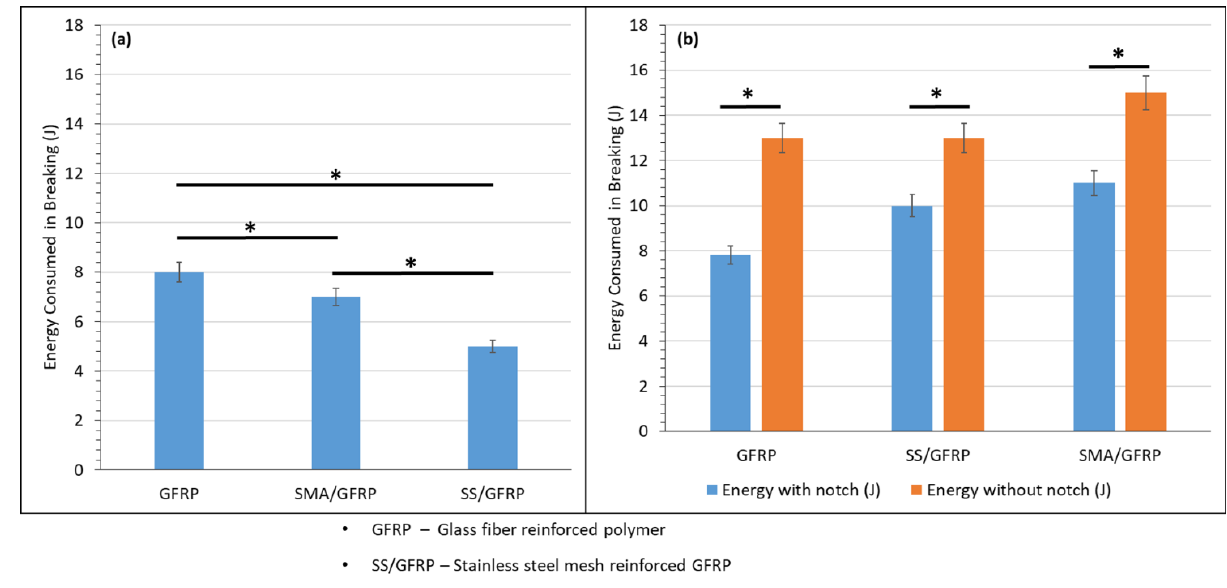
Figure 8. Results of Charpy impact test indicating energy consumed in breaking (toughness) of GFRP,